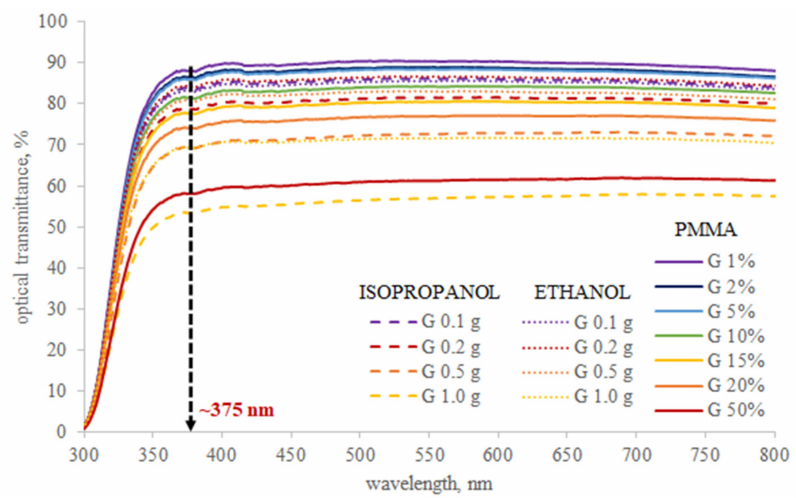
Figure 4. The optical transmittance characteristic of layers prepared with spray-coating method based on G pigment in all three variants.